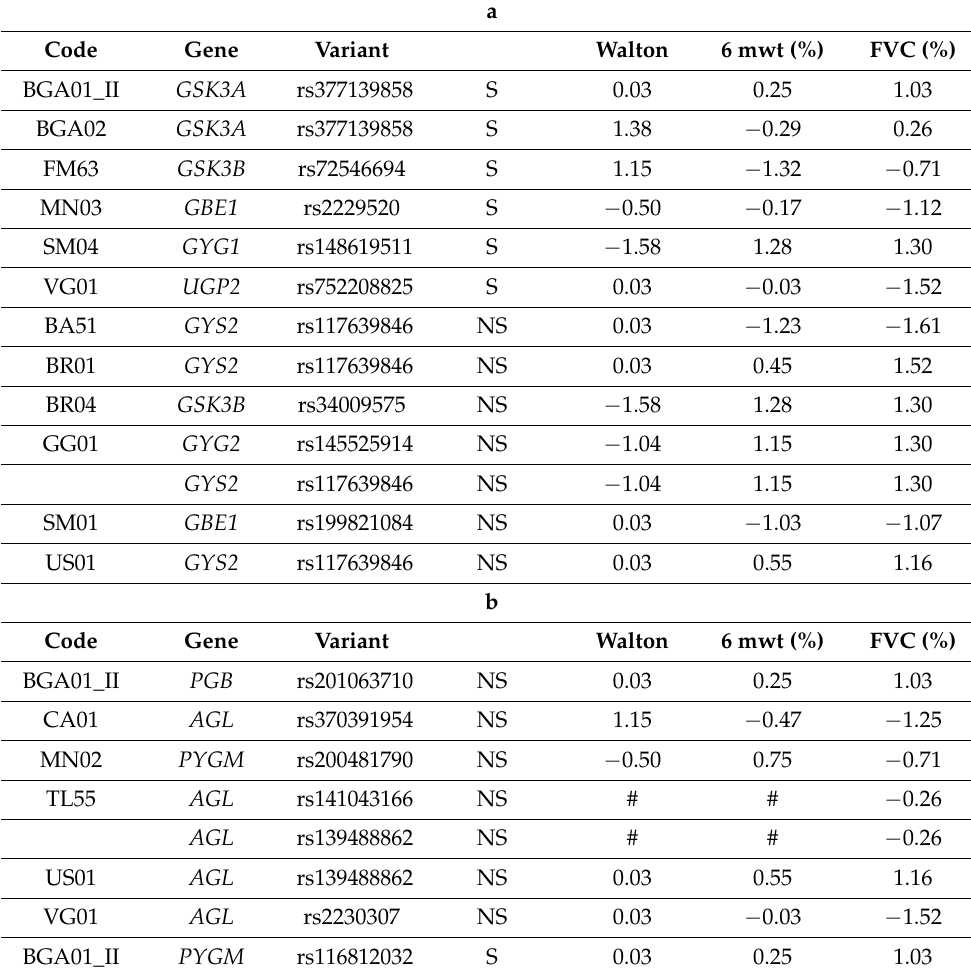
Table 5. a . Genes related to glycogen synthesis: Z score for Walton score, 6 mwt, and FVC for cases whereby a single variant is present for a specific gene or the variant has a significant difference in incidence vs. the general population. S = synonymous; NS = non-synonymous. b . Genes related to glycogen catabolism: Z score for Walton score, 6 mwt, and FVC f cases whereby a single variant is present for a specific gene or the variant has a significant difference in incidence vs. the general population. S = synonymous; NS =